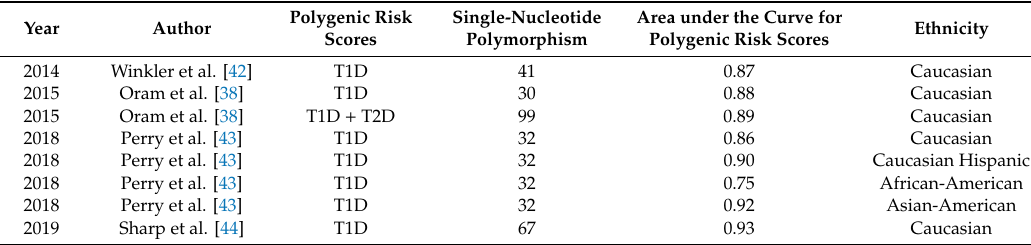
Table 3. Comparison of the accuracy of T1D PRS assessed by the